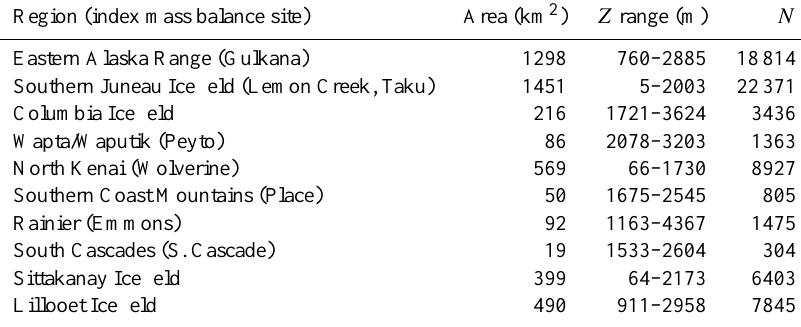
Table 1. Area, glacier elevation range, and number of possible MOD02QKM pixels ( N ) of regional icefields/glacierized regions analysed in this study. Index glacier mass balance sites included in parentheses. Area and elevation range based on GLIMS glacier outlines (Armstrong et al., 2012) and GMTED 200m digital elevation